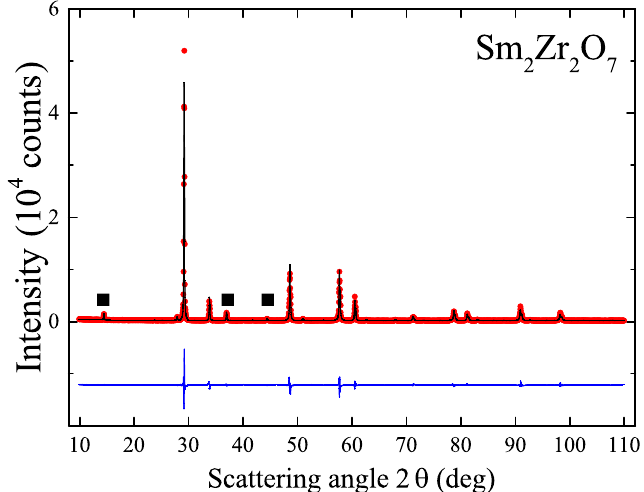
Figure 12. Powder X-ray diffraction profile of a ground crystal of Sm 2 Zr 2 O 7 prepared in oxygen, at 4 bars pressure and using a growth rate of 8 mm/h. The experimental profile (red closed circles) and a full profile matching refinement (black solid line) to the pyrochlore structure are shown, with the difference given by the blue solid line. ” (cid:110) ” indicate the low angle superlattice reflections of the pyrochlore structure.